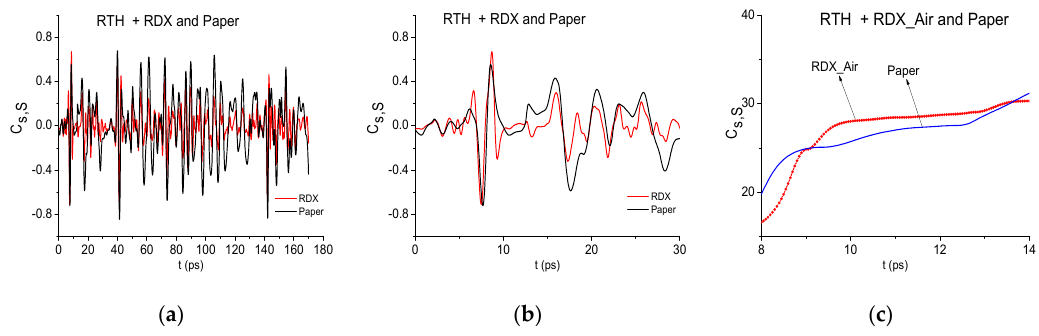
Figure 7. Correlation coe ffi cients c s , S between the RTH signal and RDX_Air standard signal (red line) as well as between RTH signal and paper standard signal (black line) computed in the time intervals t = [0,180] ps ( a ) and [0,30] ps ( b ). ICC C s , S computed between these signals in the time interval t = [8,14] ps ( c ).